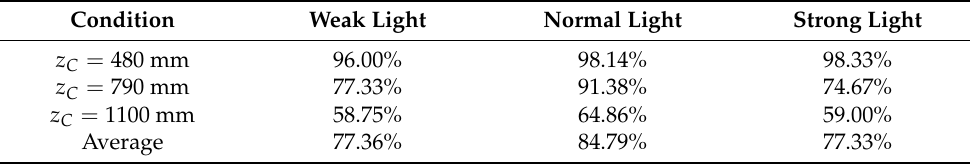
Table 1. Success rate of beacon straight–line feature extraction under different conditions.